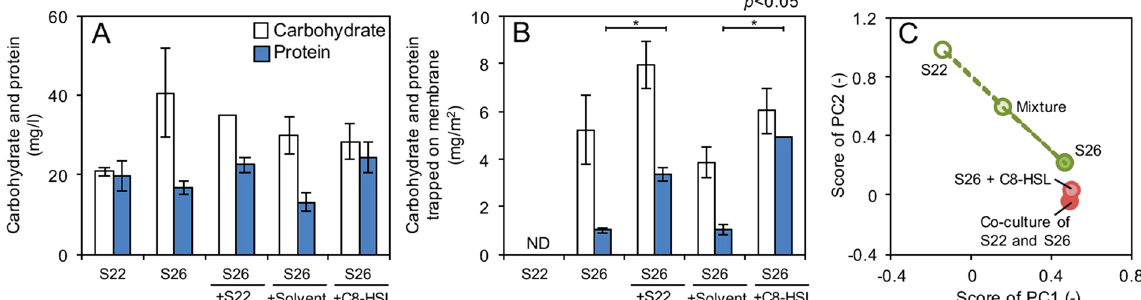
Figure 5. ( A ) Carbohydrate and protein concentrations in soluble microbial product (SMP) produced by S22, S26, S22 + S26 (co-culture) and S26 cultured with C8-HSL (4.4 μ M). ( B ) Carbohydrate and protein contents in SMP trapped on membrane surface in the dead-end filtration experiment for these cultures. The error bars indicate the standard deviations of two independent experiments. The bar following sign indicates statistical difference between two groups with respective p value: * P < 0.05. ( C ) Principal compartment analysis based on fourier transform infrared (FTIR) spectrum of SMP. “Mixture” indicates the mixture of the SMP produced by strain S22 and S26 with a ratio 1:1. The SMP produced by co-culture was close to the SMP produced by S26, indicating that the co-culture SMP was mostly produced by strain